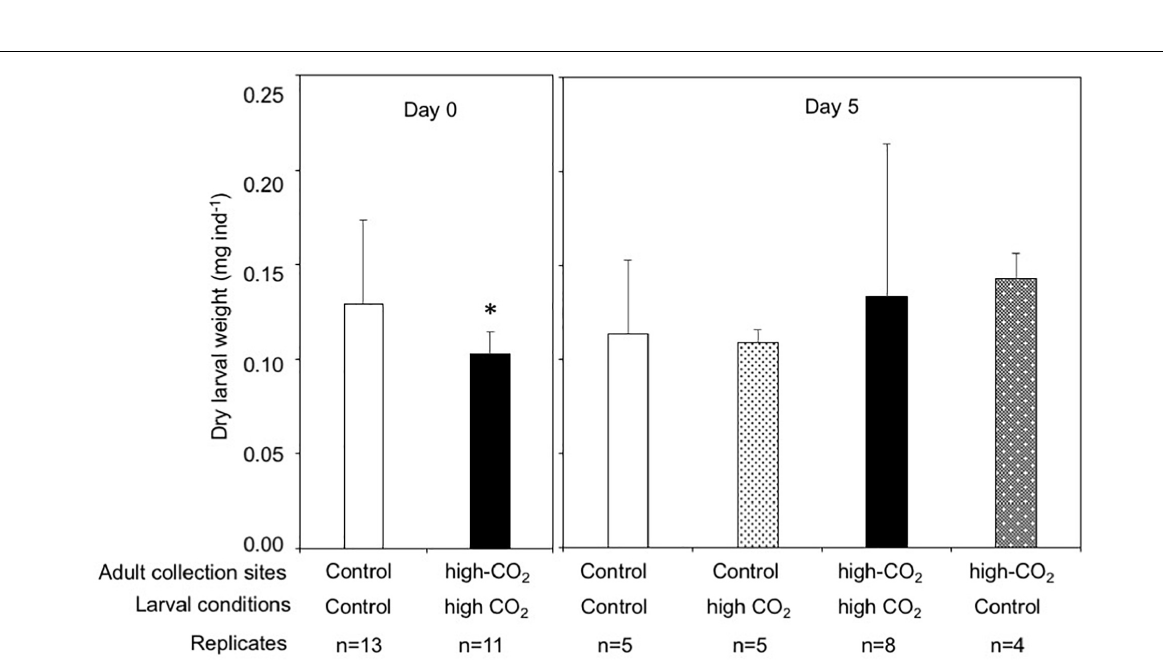
Frontiers in Marine Science |